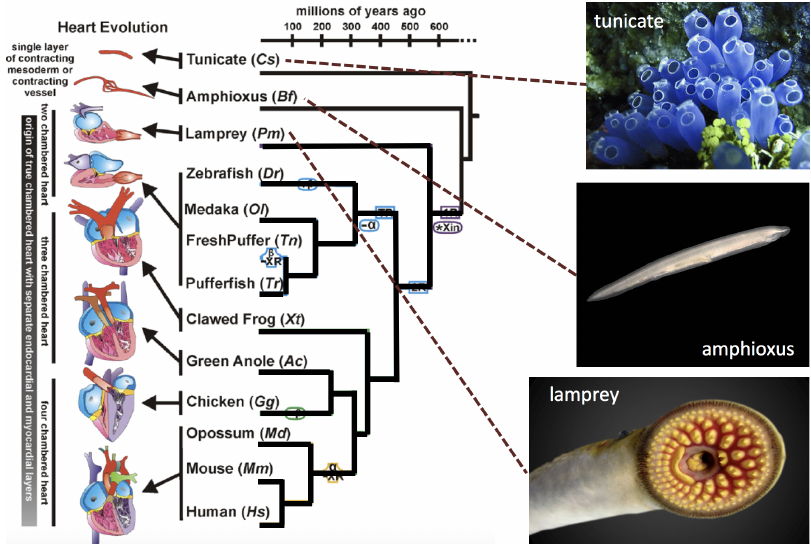
Fig. 1: Figure adapted from Grosskurth et al. [5] illustrating the evolution of hearts from the valveless heart tubes in the open circulatory systems of tunicates to the adult multi-chambered-valvular of vertebrates. Tunicate, amphioxus, and lamprey images adapted from [6], [7], [8], respectively.